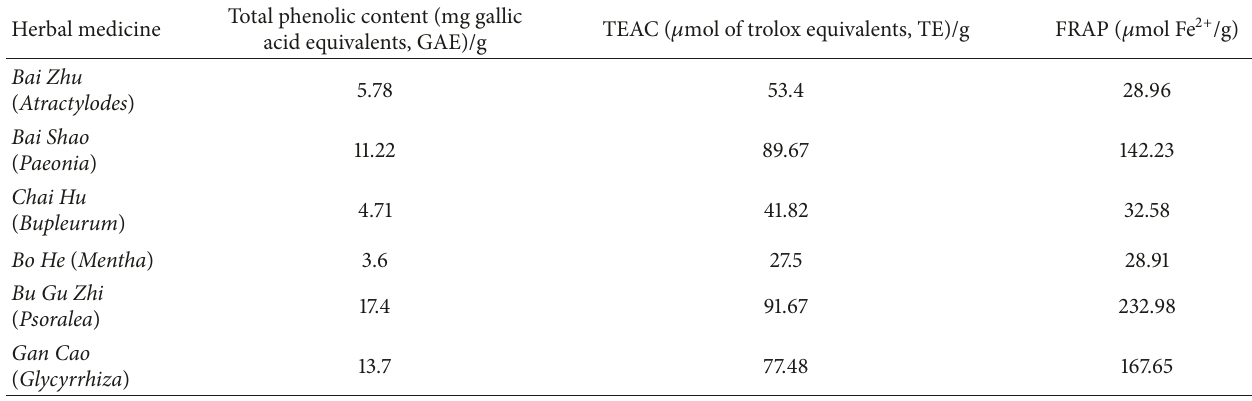
Table 2: Total phenolic content and antioxidant activity of CHM